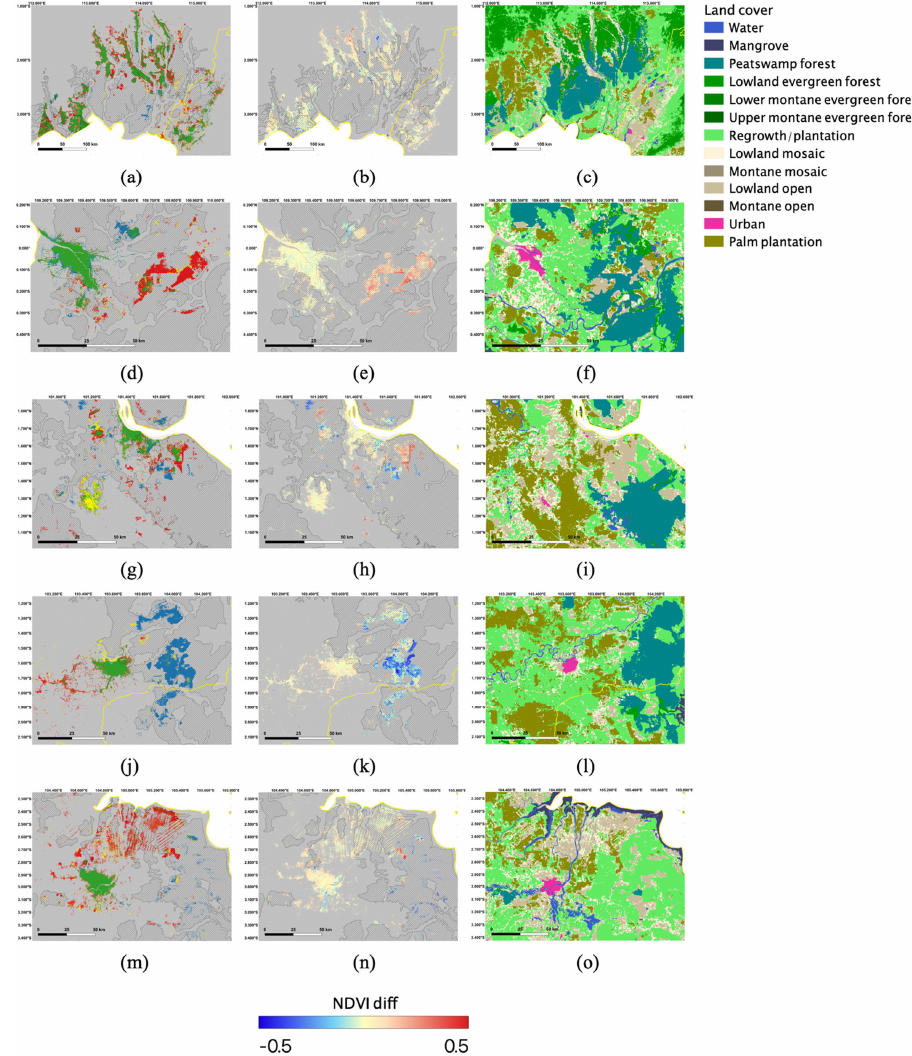
Figure 14. Results of processing and Land cover maps. ( a ) Color map for Frames 1, 2, and 3. ( b ) NDVI diff for Frames 1, 2, and 3. ( c ) Land cover map for Frames 1, 2, and 3. ( d ) Color map for Frame 4. ( e ) NDVI diff for Frame 4. ( f ) Land cover map for Frame 4. ( g ) Color map for Frame 5. ( h ) NDVI diff for Frame 5. ( i ) Land cover map for Frame 5. ( j ) Color map for Frame 6. ( k ) NDVI diff for Frame 6. ( l ) Land cover map for Frame 6. ( m ) Color map for Frame 7. ( n ) NDVI diff for Frame 7. ( o ) Land cover map for Frame